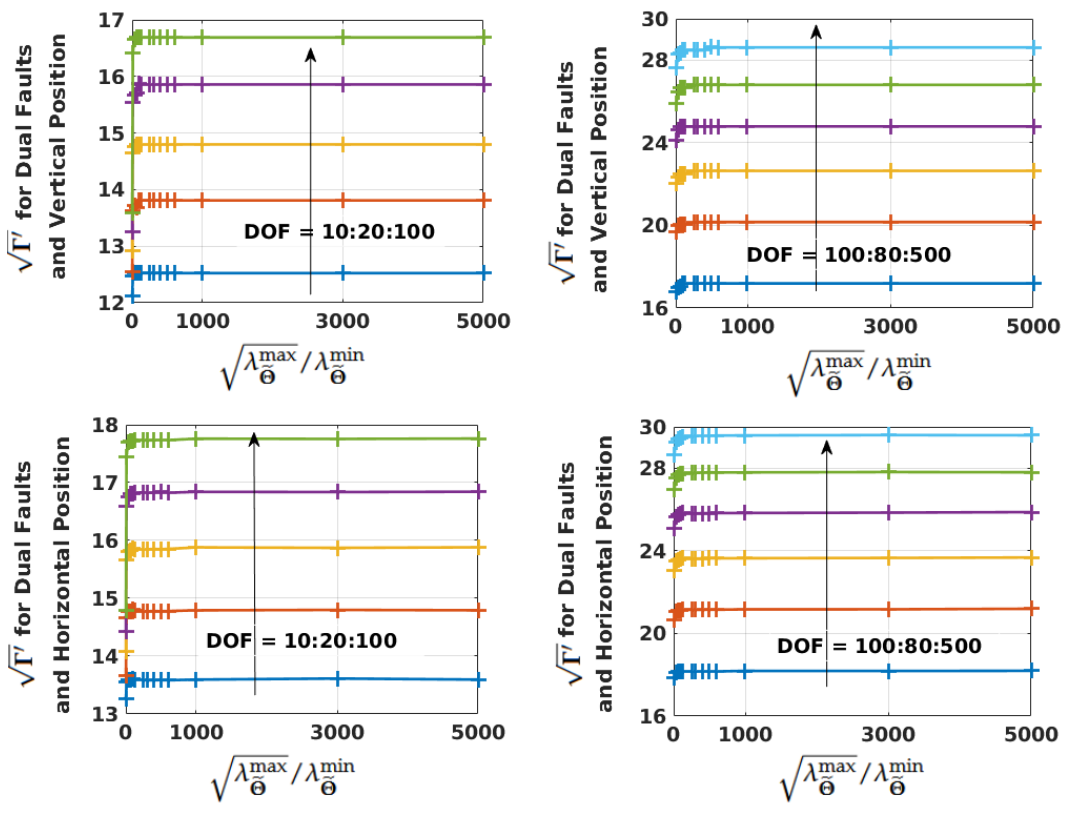
√ Γ (cid:48) with (cid:113) λ max